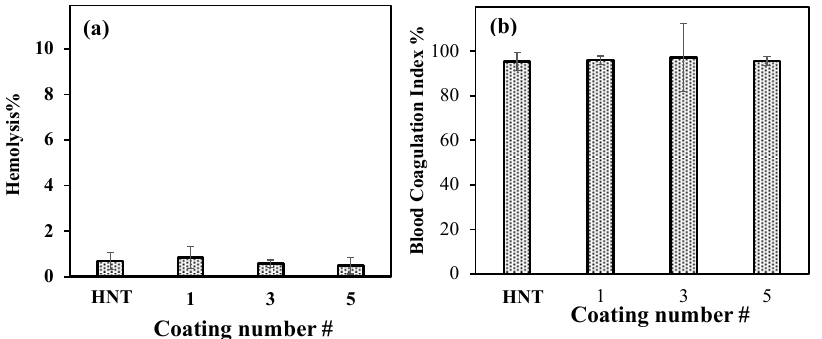
Figure 7. ( a ) Hemolysis percentage and ( b ) blood coagulation index percentage of neat HNT and PDOPA1@HNT, PDOPA3@HNT and PDOPA5@HNT at 2.0 mg/mL concentration.